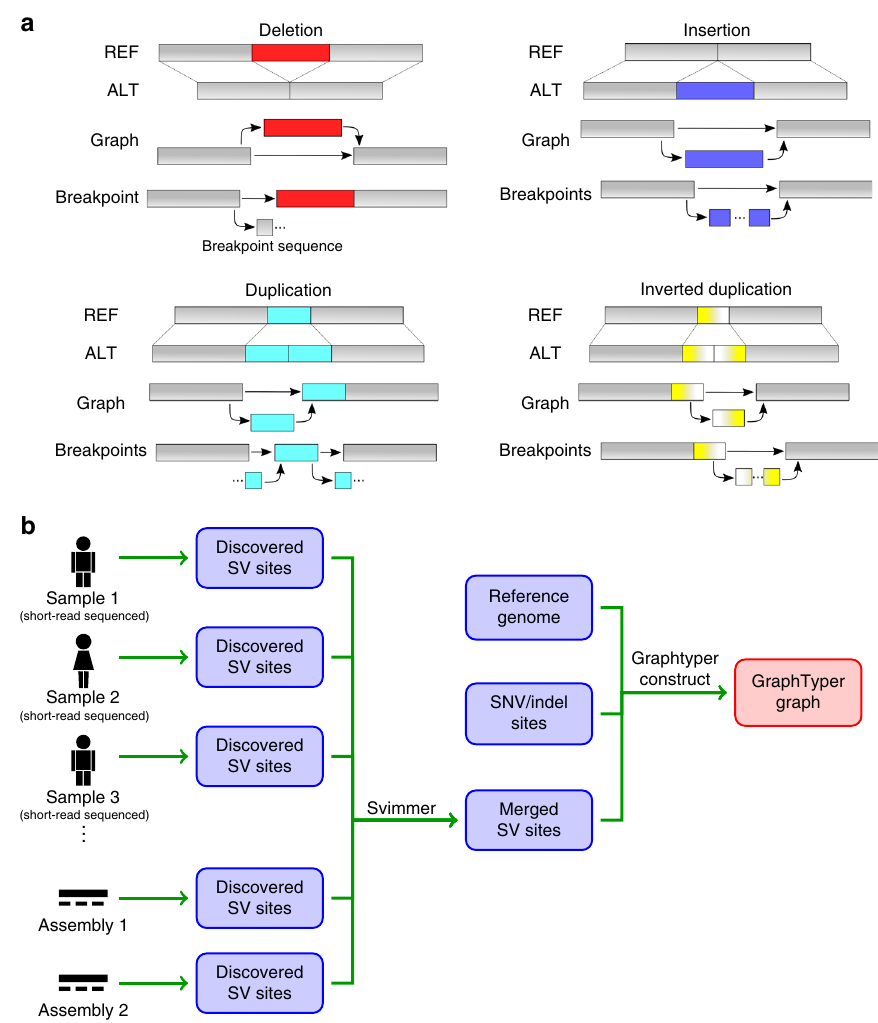
Fig. 1 Overview of data structure and work fl ow. a Example structural variants and their encoding in an acyclic graph structure. b Work fl ow for constructing a GraphTyper graph with SNPs, indels and SVs. SVs are detected from each sample independently and then merged across all the samples, such that SV sites of the same type and similar position and size are reported only once. SNPs and indels that are given as input into the graph construction can be detected using GraphTyper or obtained from a